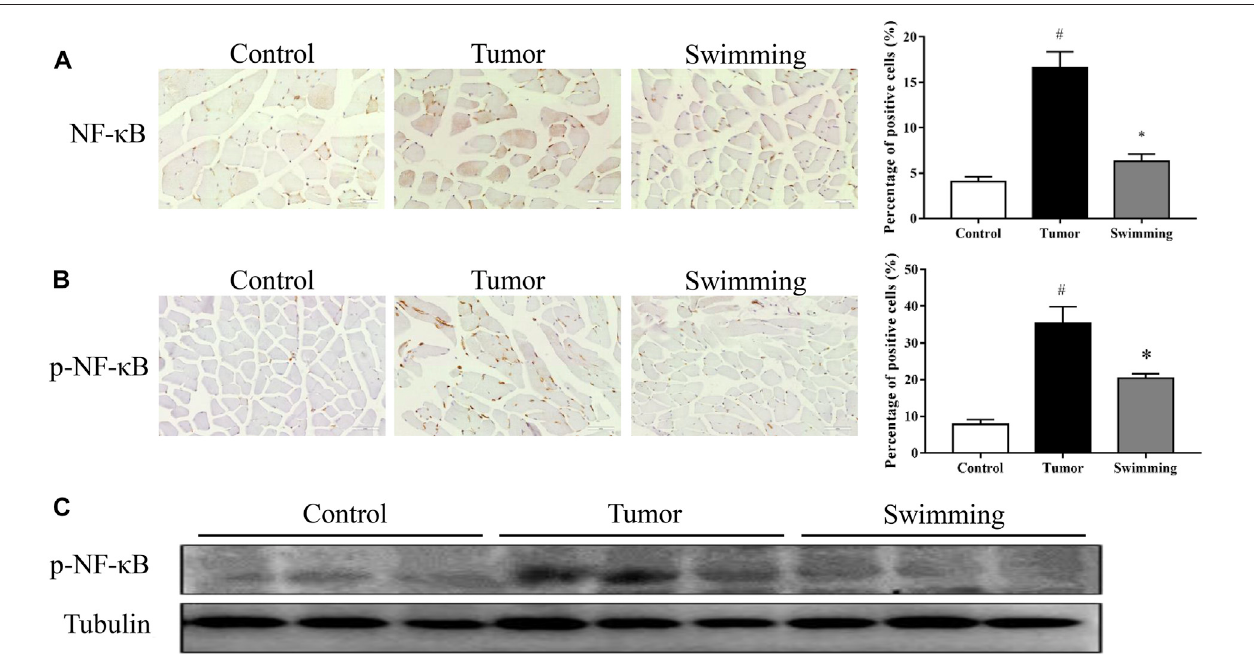
FIGURE 6 | Effects of swimming on NF- κ B signaling pathway. The protein levels of (A) NF- κ B and (B) p-NF- κ B in quadriceps muscle tissues of mice from each group wasdetermined byIHCanalysis.Theimages weretakenat amagni fi cation of × 400bymicroscopy.The cellswithbrown stainingwerede fi nedaspositivestained cells. (C) The protein expression of p-NF- κ B in quadriceps muscle tissues for each group was determined by Western-blot analysis. The tubulin was used as a loading control. Data were presented as mean ± SD. # p < 0.05 vs . Control group; * p < 0.05 vs . Tumor